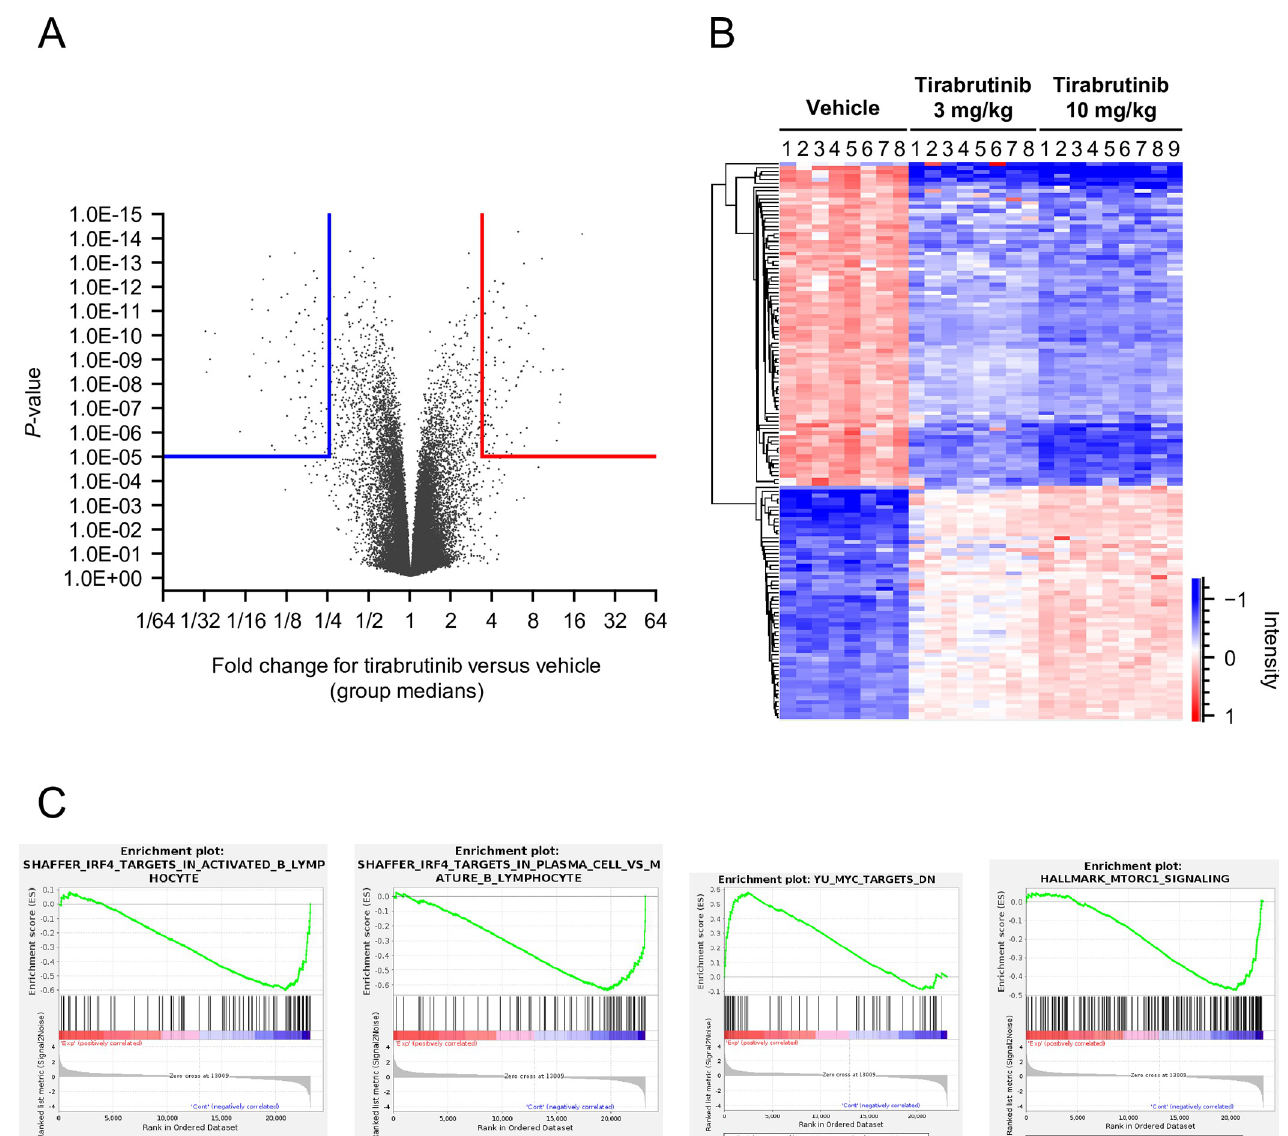
Fig 6. Global gene expression analysis of response to tirabrutinib treatment in a TMD-8 xenograft model. Microarray analysis was conducted in the TMD8 xenograft model after 21 days of tirabrutinib administration. (A) Volcano plot for differential gene expression between the vehicle and tirabrutinib 10 mg/kg group with Welch’s t test. (B) Heat map of top altered gene group including 59 upregulated probes and 87 downregulated probes (fold change, > 4 or < 0.25; P < 0.00001) in the vehicle, tirabrutinib 3 mg/kg, and 10 mg/kg groups. (C) Gene set enrichment analysis (GSEA) plots involved in IRF4, MYC, and mTORC1 signaling in the tirabrutinib 10 mg/kg group versus vehicle